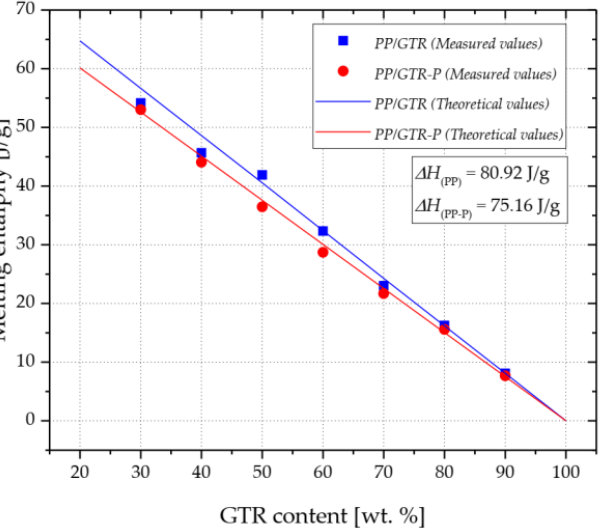
Figure 13. Theoretical and measured values of melting enthalpy of PP/GTR and PP/GTR-P. The melting enthalpy determined by calorimetric tests of samples was compared to the theoretical values of the enthalpy determined by measurements of the melting enthalpy of unfilled PP and PP-P samples (Figure 13). It was found that the values of the melting enthalpy determined for samples of PP/GTR and PP/GTR-P compounds with different contents of rubber filler in the material are similar to the calculated theoretical values of this parameter. The greatest differences were observed in the case of PP/GTR30 and PP/GTR40 samples, which indicates differences between the assumed and real rubber filler content in the tested samples. The PP/GTR30 compound was characterized by being less than 4 percentage points higher than the assumed rubber content, and in the case of the PP/GTR50 composition, the filler content was over 2.5 percentage points lower (Table 4). The determined differences between the real content of the filler in the composition and the assumed values may be the result of the specificity of the applied technologies for mixing the components and the preparation of test samples. Another reason may be the specificity of the calorimetric test, in which the mass of the tested sample was about 10 mg, i.e., about 0.015% of the weight of the moldings made of PP/GTR50. Table 4. Results of calorimetric